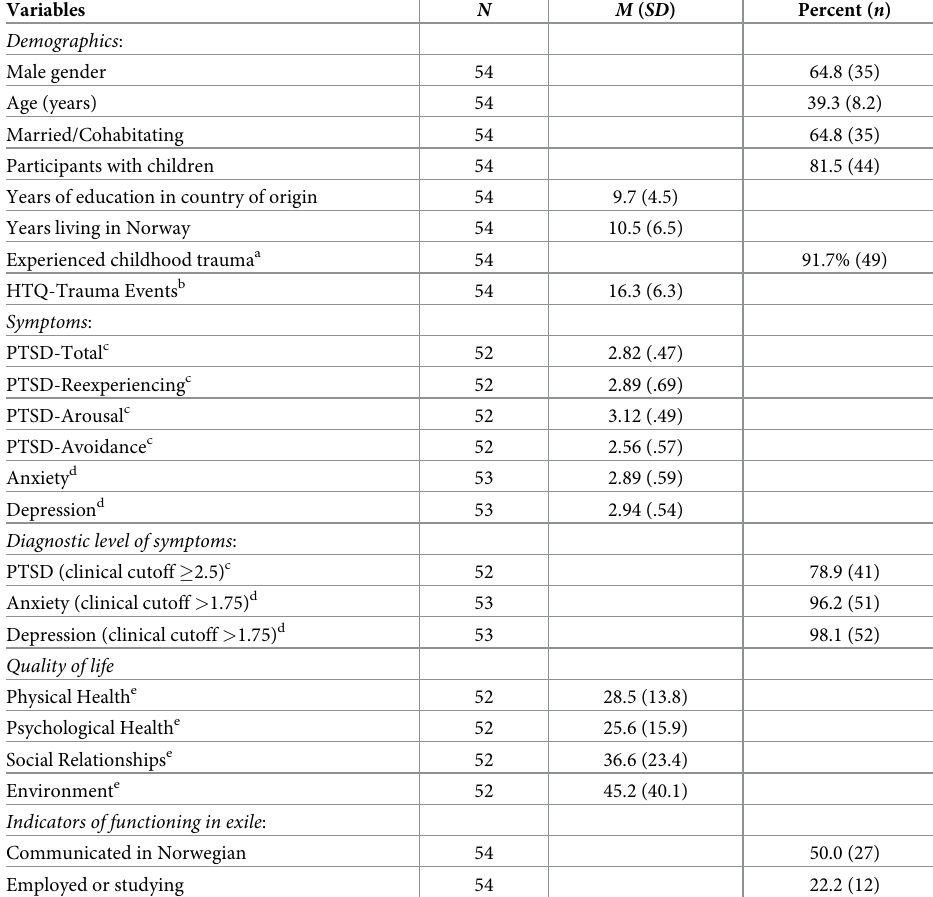
Table 1. Demographics, mental health symptoms, quality of life, and indicators of functioning in exile upon entering therapy and the